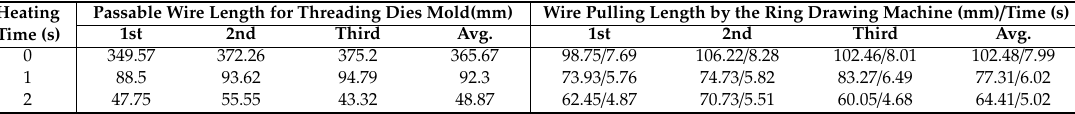
Table 7. Results based on wire pulling speed: k7(12.83 mm / s).